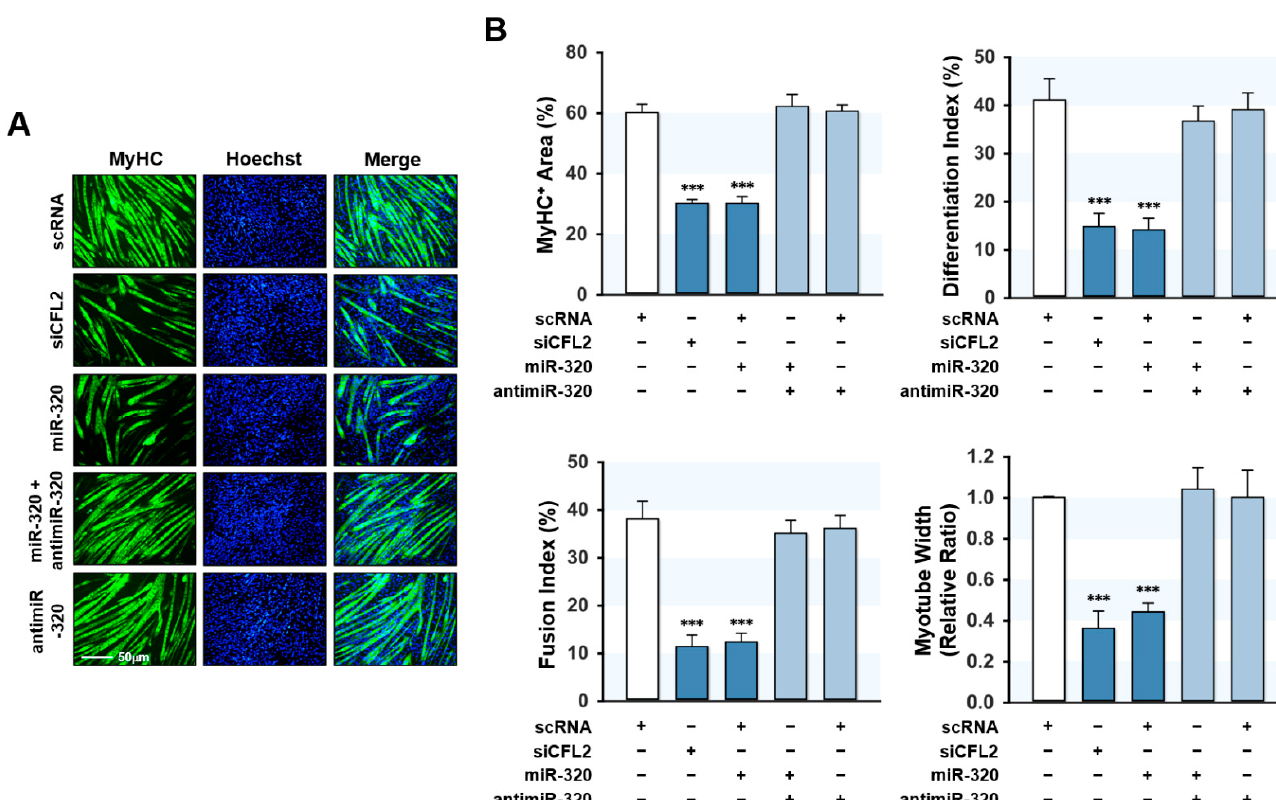
Figure 6. MiR-320-3p impeded the differentiation of myoblasts. Cells were transfected with scRNA, siCFL2, miR-320-3p mimic (miR-320), or antimiR-320-3p (antimiR-320) and differentiated for 5 days. ( A ) Immunocytochemical staining of MyHC (green) at day 5 of differentiation. Nuclei were stained with Hoechst 33342 (blue). Scale bar, 50 µ m. ( B ) MyHC-positive area, myotube width, differentiation index, and fusion index were quantitated with ImageJ software. Results are means ± SEMs ( n > 3). ***, p < 0.001 vs. scRNA control.